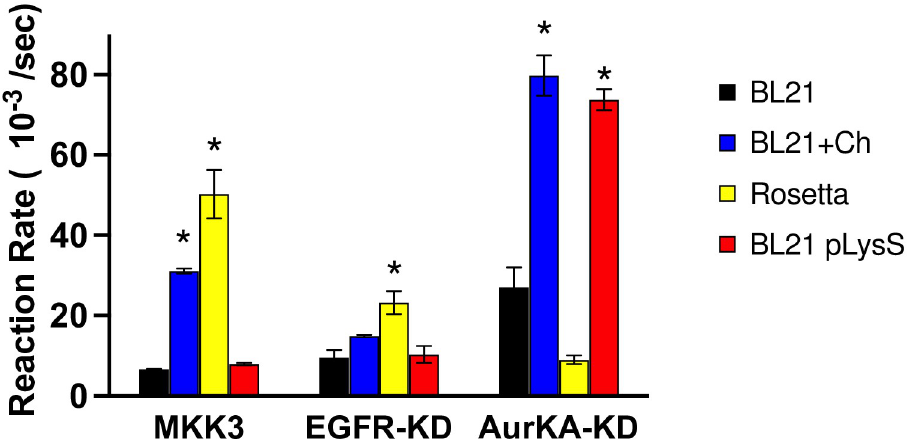
Fig 6. Activity of the purified kinases. The phosphorylation reaction rate for the purified enzymes in the different expression strains/conditions using the coupled kinase assay as detailed in the Materials and Methods section.